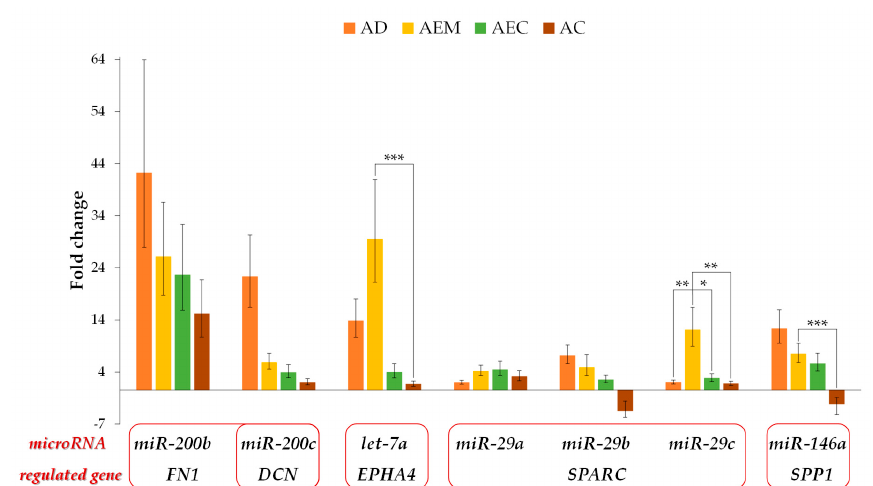
Figure 4. Expression of potential regulatory microRNAs in adenoma, adenoma with epithelial misplacement, adenoma with early carcinoma and advanced carcinoma. Expression is plotted as fold change against healthy colon mucosa. Legend: * p < 0.0125, ** p < 0.01, *** p ≤ 0.001; AD, adenoma; AEM, adenoma with epithelial misplacement; AEC, adenoma with early carcinoma; AC, advanced carcinoma.